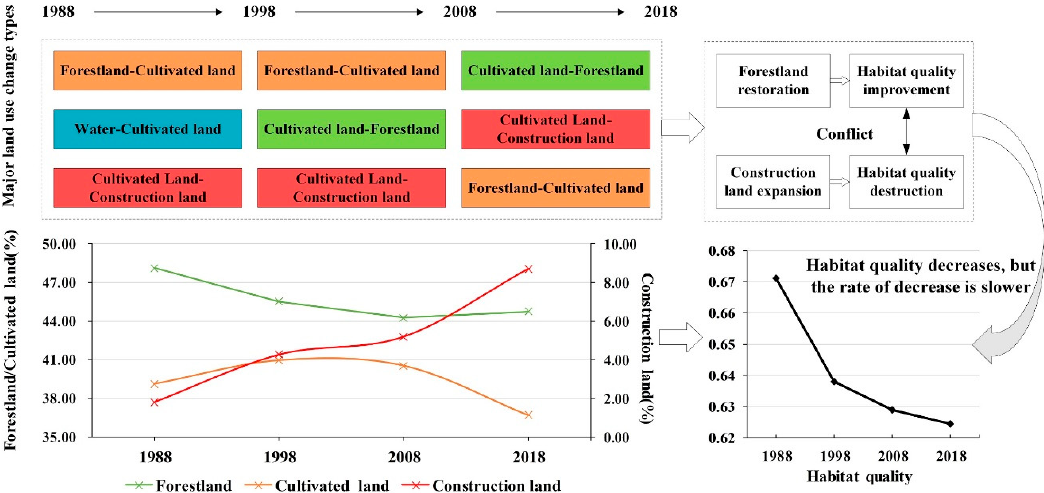
Figure 12. The logical framework of habitat quality changes in the PLEEZ.